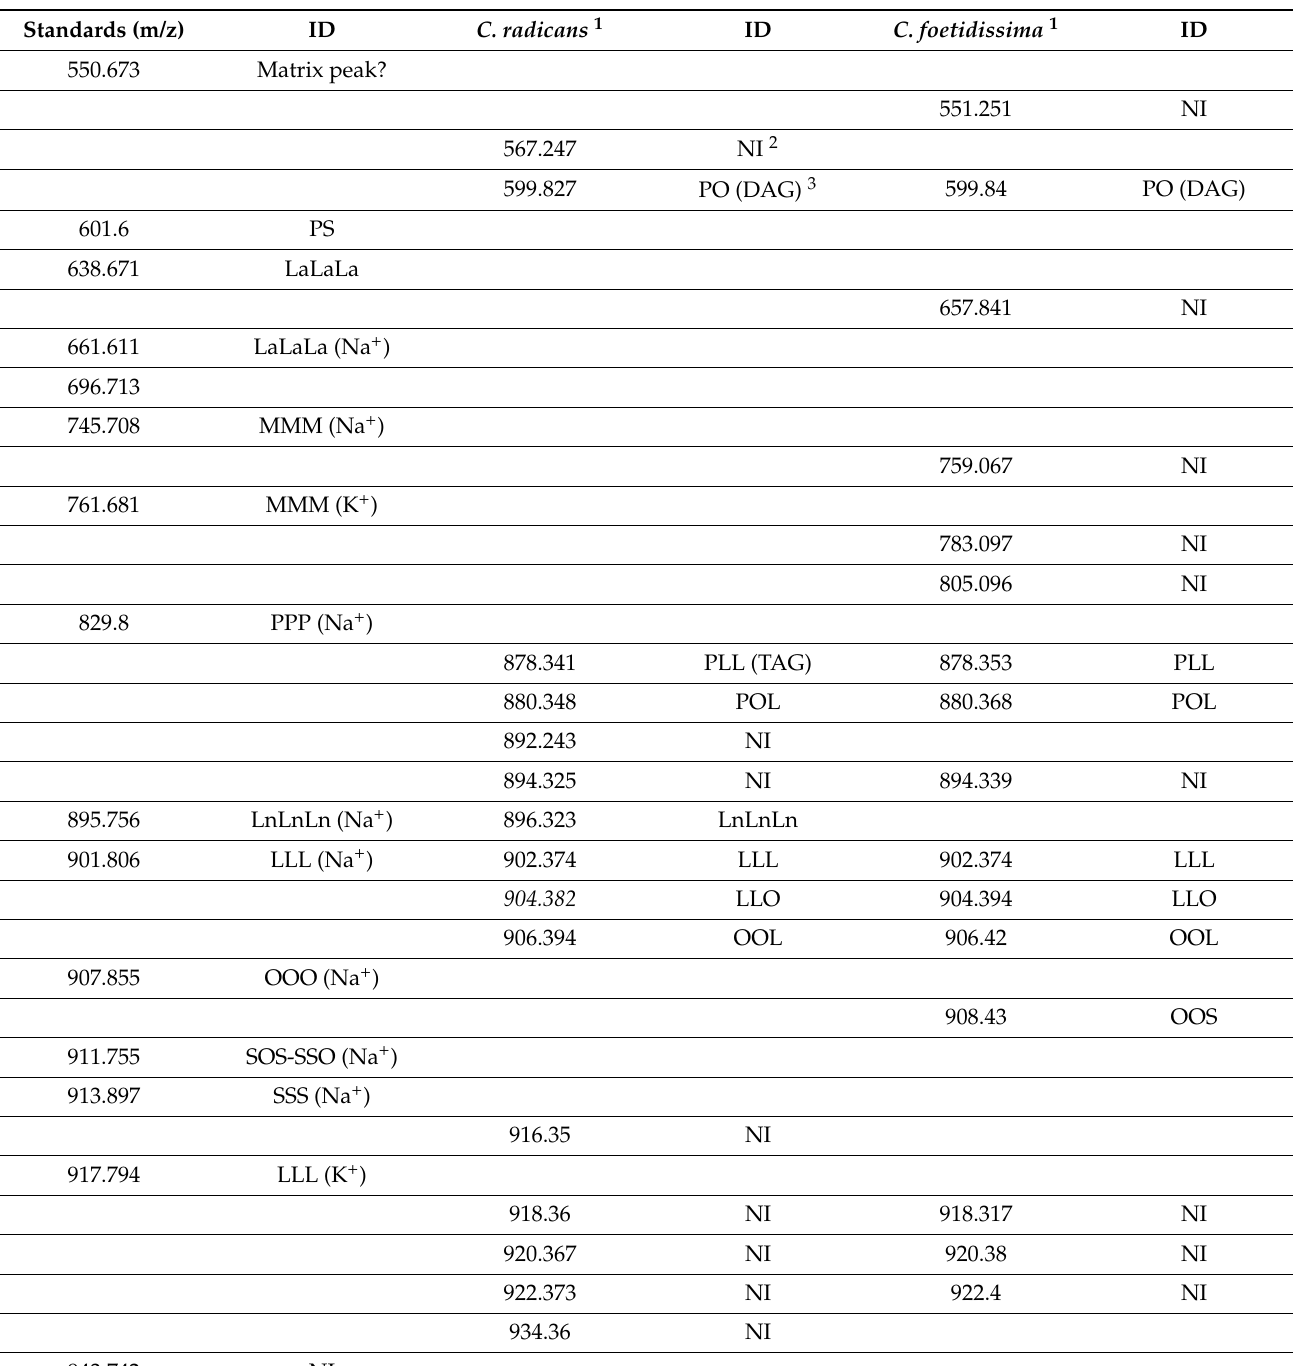
Table 3. Fatty acid composition of Cucurbita seed oils. The composition of the oils extracted from seeds of C. radicans and C. foetidissima was determined by MALDI-TOF. The identity of the most relevant m/z ions was determined on the basis of the standards shown and on published